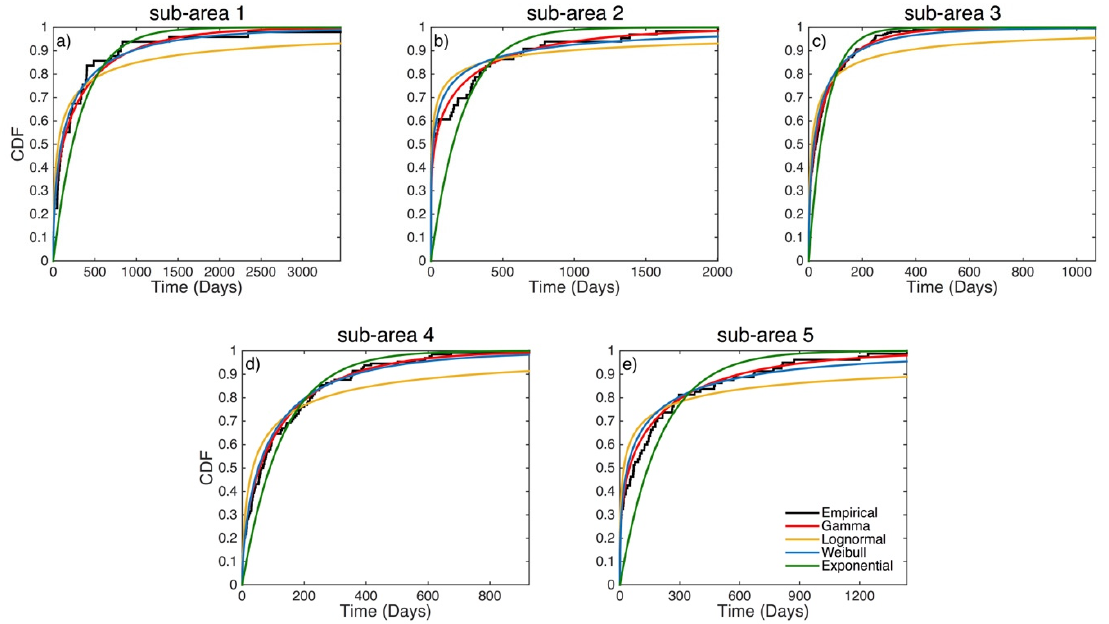
Figure 7. Comparison of empirical cdf (black lines) and the cdfs of Gamma (red lines), Lognormal (yellow lines), Weibull (blue lines) and Exponential (green lines) applied distributions for sub-areas 1 to 5 (subplots a – e ).